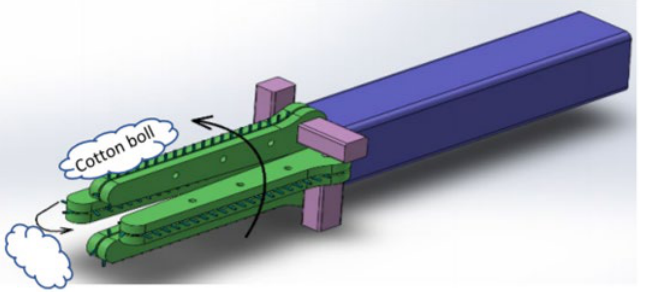
Figure 1. Preliminary design of an end-effector for cotton boll removal [73]. Adapted from Gha- rakhani and Thomasson